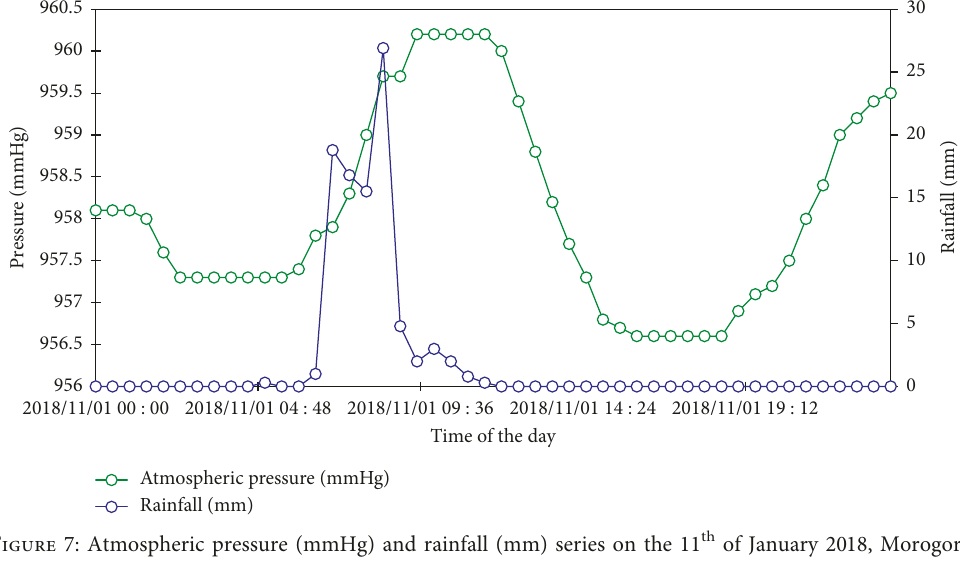
Figure 7: Atmospheric pressure (mmHg) and rainfall (mm) series on the 11 th of January 2018, Morogoro.